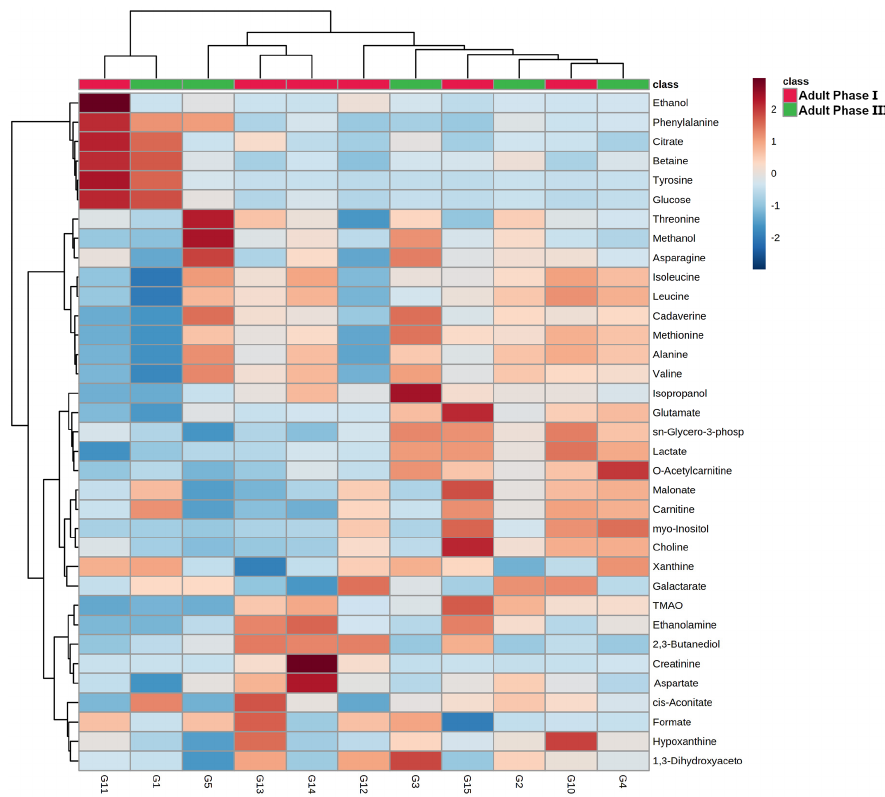
Figure 4. Heatmap built on the metabolomic space constituted by the concentrations of the molecules quantified by 1 H-NMR.